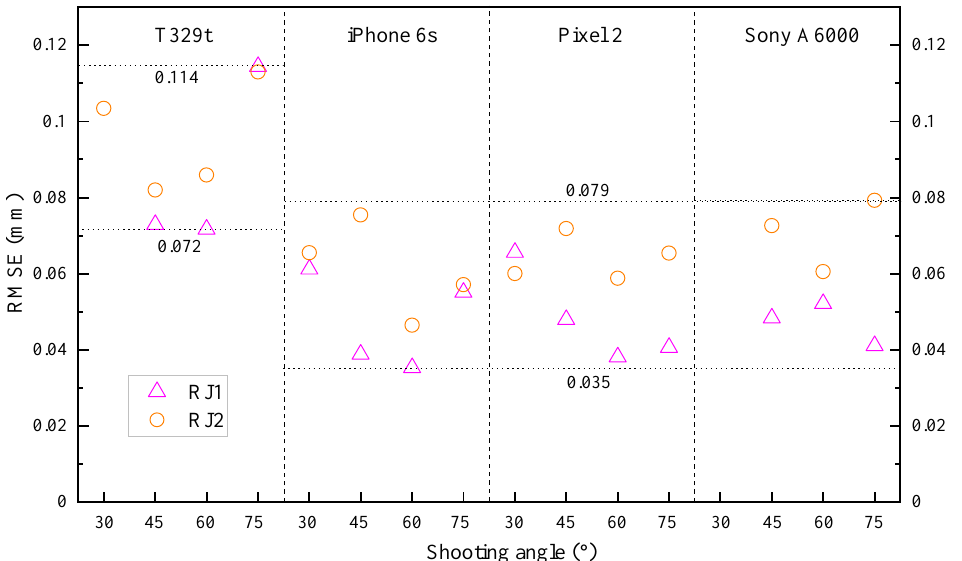
Figure 9. The root mean square error (RMSE) of the SfM models of RJ1 and RJ2 with the different cameras and different shooting angles under the FSC mode.